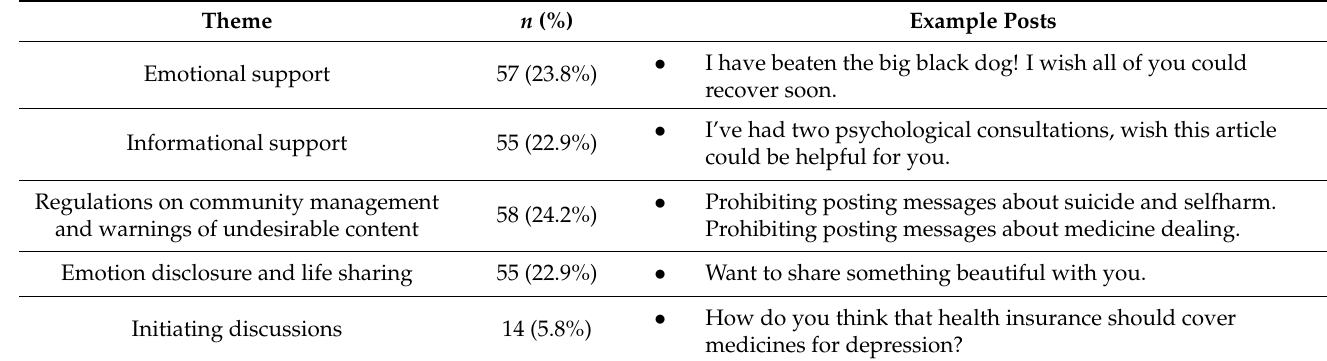
Table 1. Themes of distilled posts and sample posts.